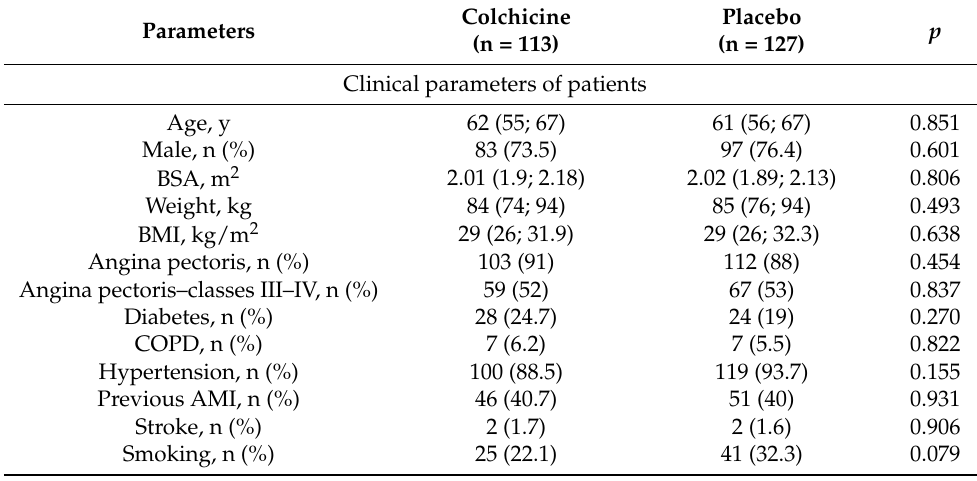
Table 1. Patient parameters according to the initial